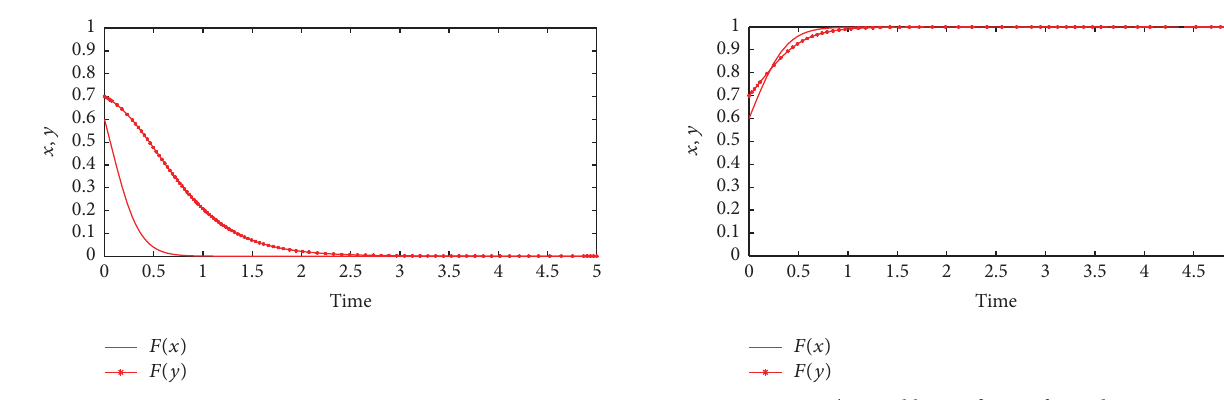
Figure 4: The equilibrium figure after 1st step game.